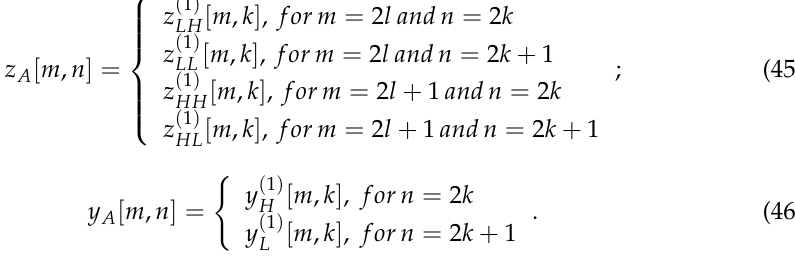
Figure 12. The block diagram of the proposed 2 ‐ D inverse DWT 5/3 architecture.